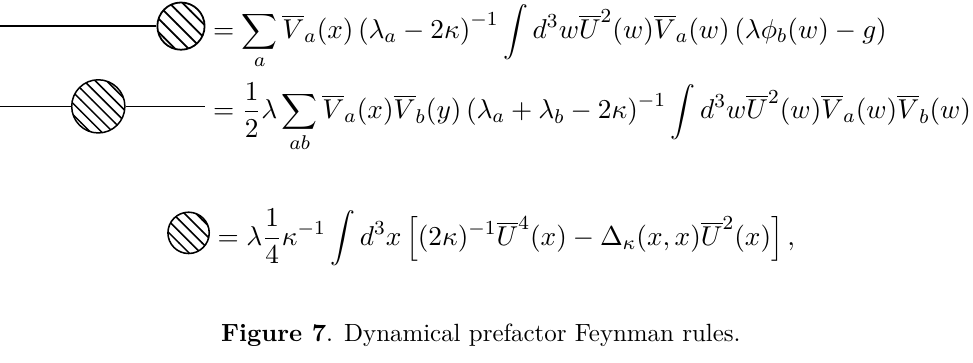
Figure 7 . Dynamical prefactor Feynman